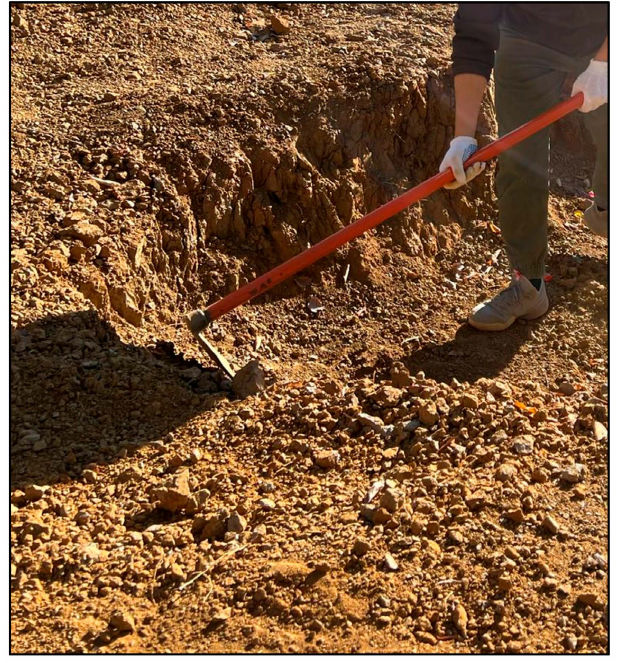
Figure 1. Test soil.